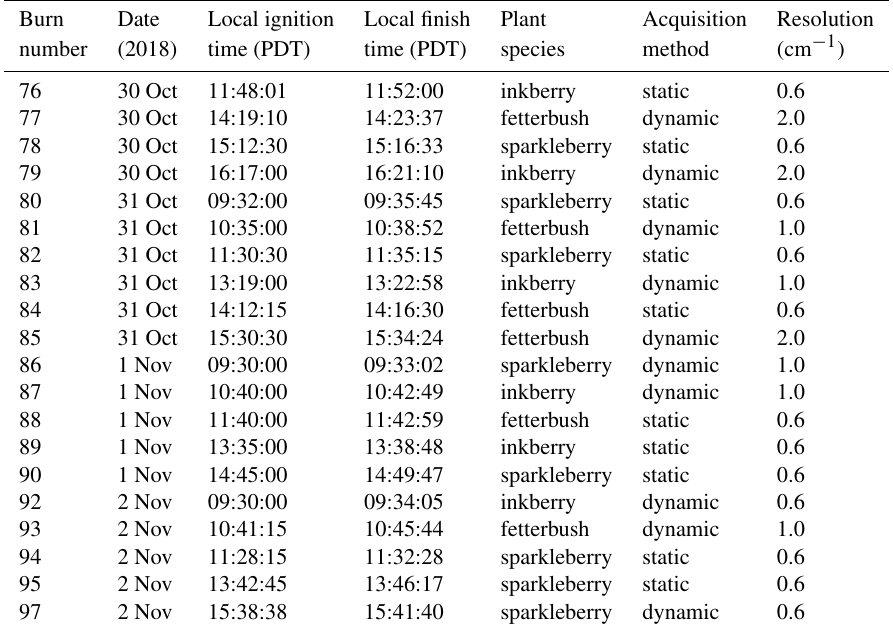
Table 1. Summary of burn schedule for November 2018 studies including burn number, date and time, fuel description, acquisition method, and spectral resolution used for wind tunnel experiments under 1ms − 1 of imposed airflow. The harmonic mean flame spread rate is 0 . 01ms − 1 . The FTIR acquisition methods are described in the